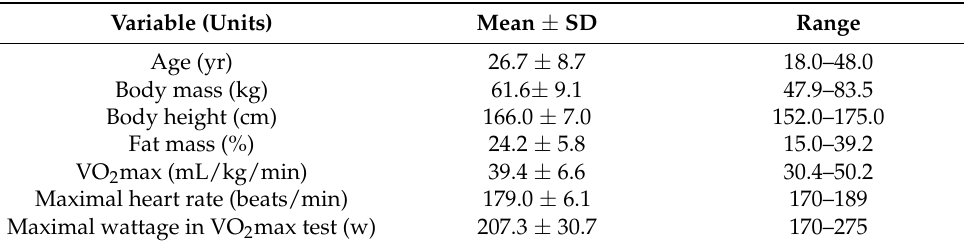
Table 1. Participants’ age, morphological characteristics, and maximal values at the end of a VO 2 max test on a cycle